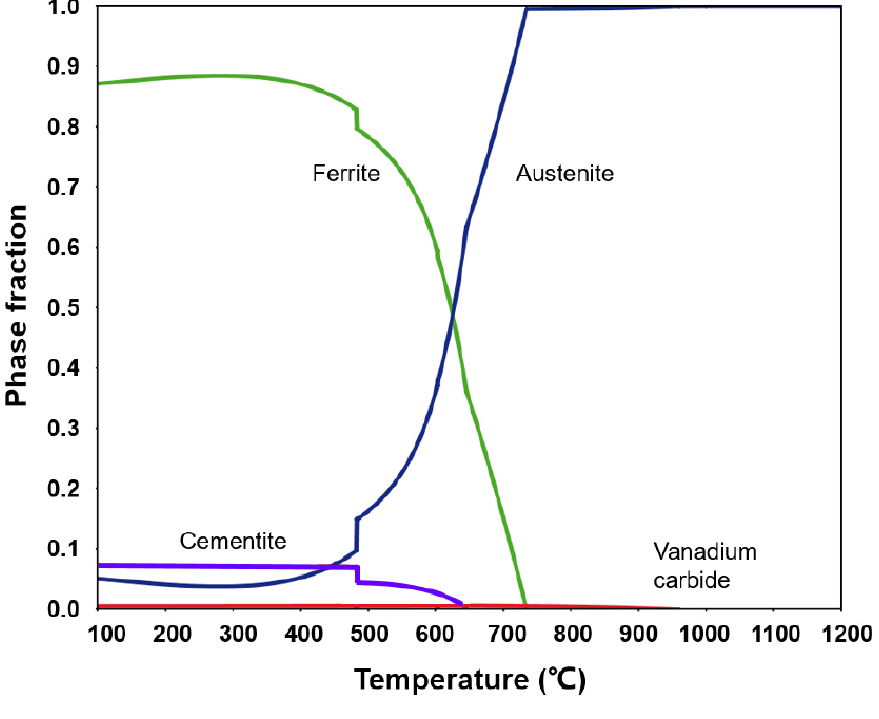
Figure 1. Equilibrium phase fraction of studied steel at different temperatures calculated by Thermo-Calc.